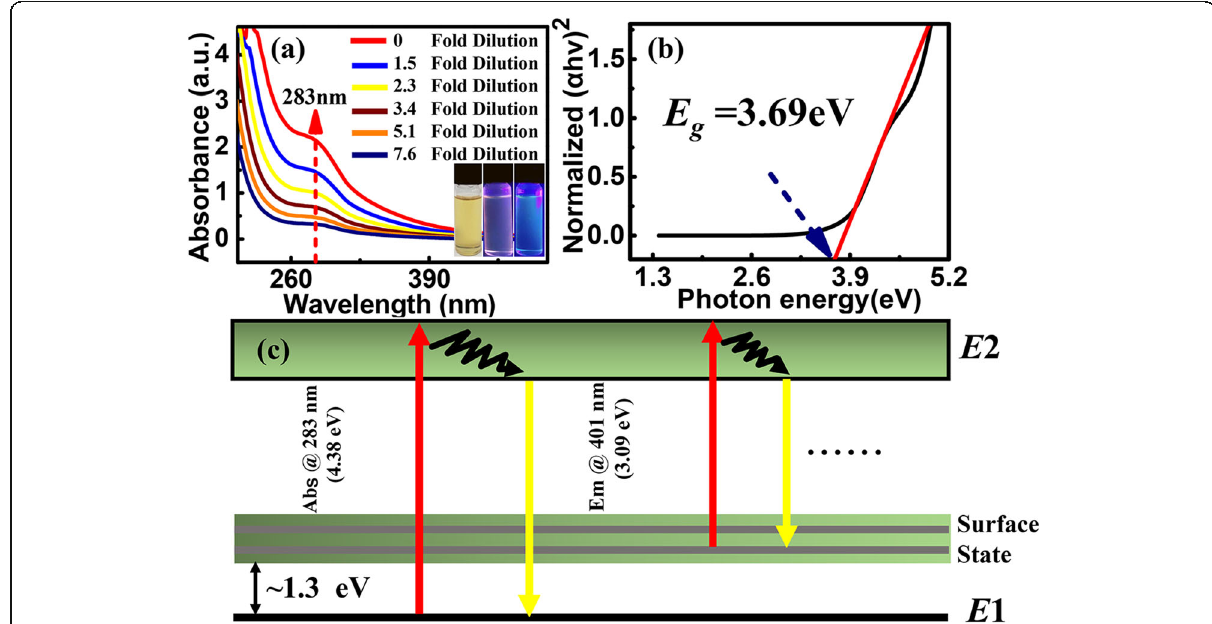
Fig. 4 a UV-Vis absorption spectra of TaS 2 QDs and TaS 2 QDs in natural light, 254 nm and 365 nm UV light illumination; b the direct band gap spectrum of the TaS 2 QDs by Tauc method; c energy level diagram of TaS 2